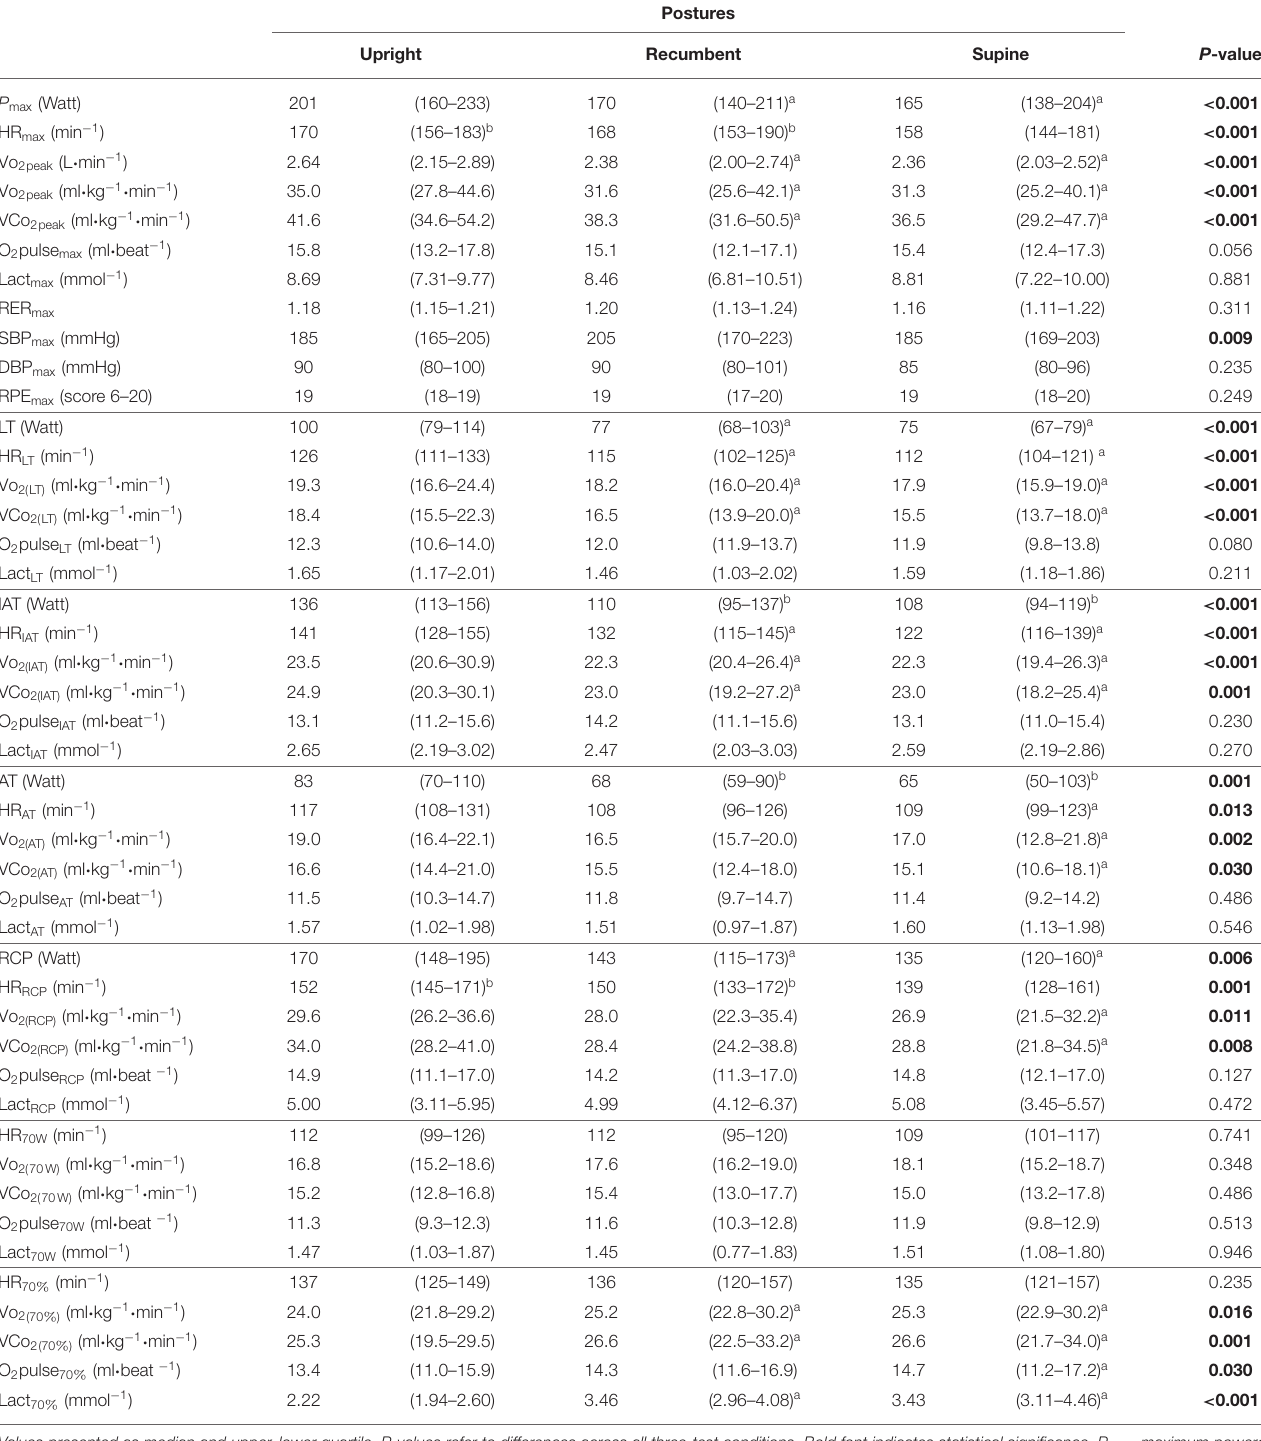
TABLE 1 | Results of cardiopulmonary exercise testing in three different cycling